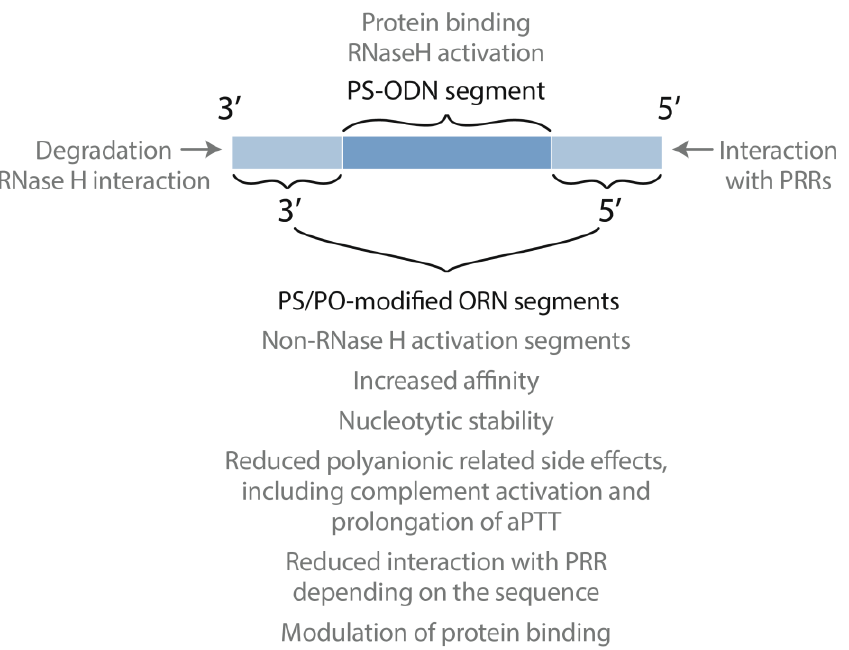
Figure 2. Design of mixed backbone antisense oligonucleotides.